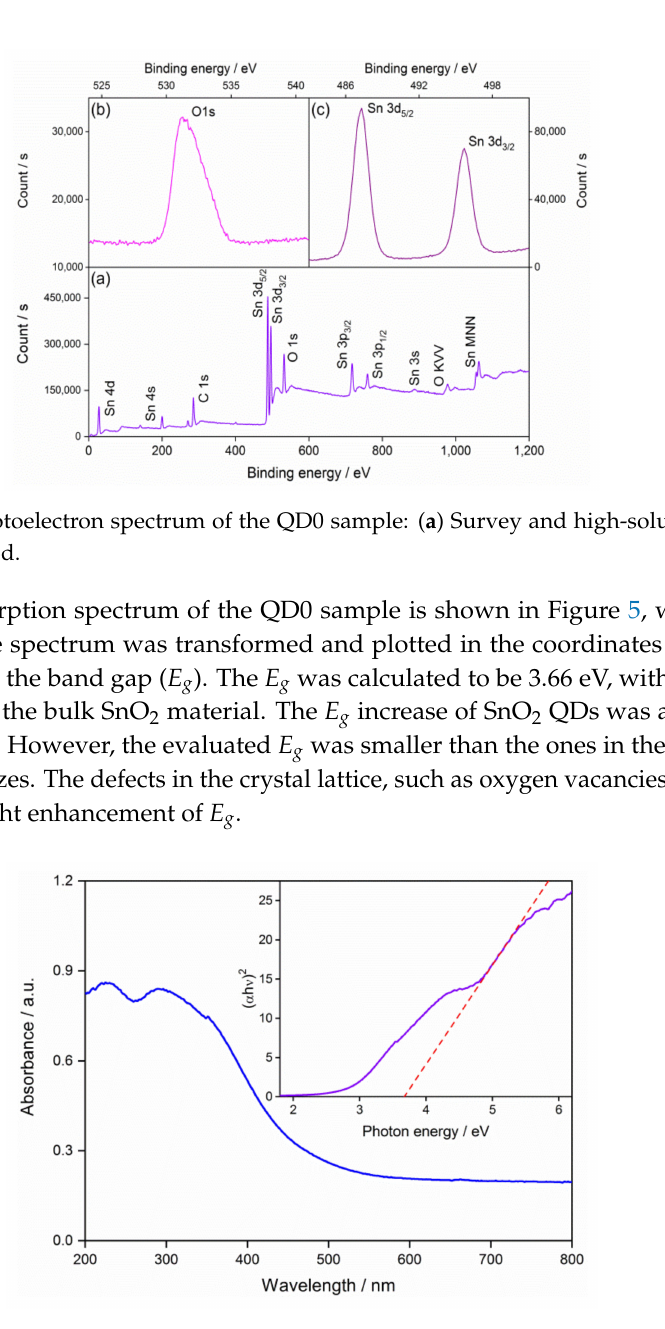
Figure 5. Ultraviolet-visible absorption spectrum of the QD0 sample and the evaluation of band gap ( E g